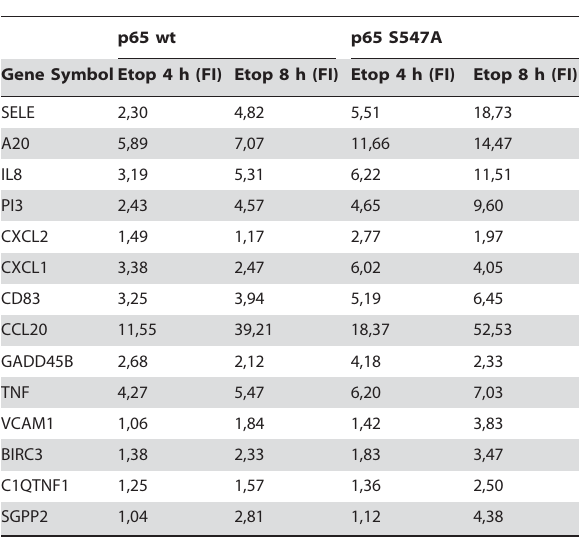
Table 1. Genes regulated by p65 Ser 547 phosphorylation.